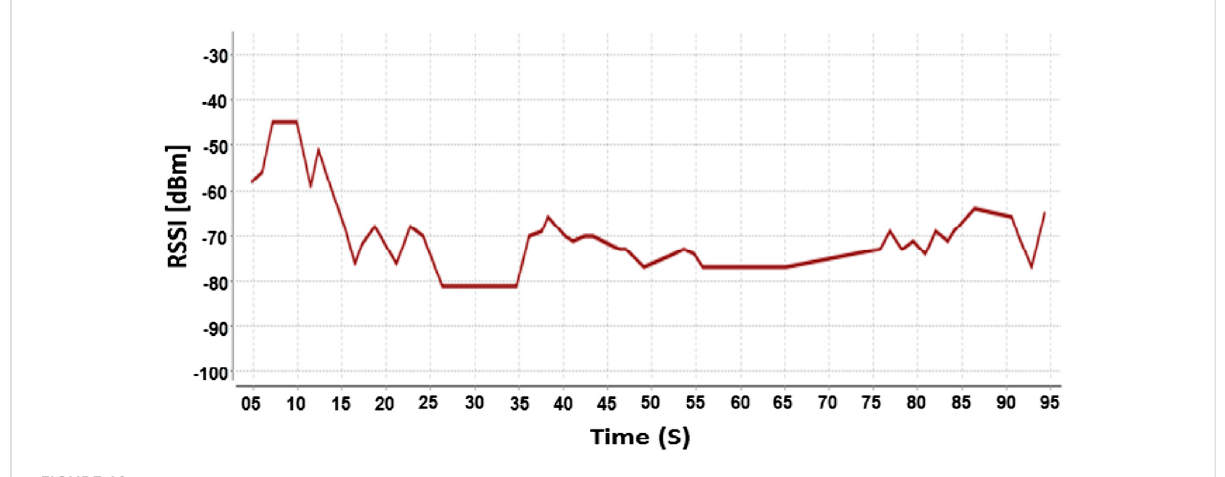
FIGURE 10 RSSI chart of the ZigBee end device.